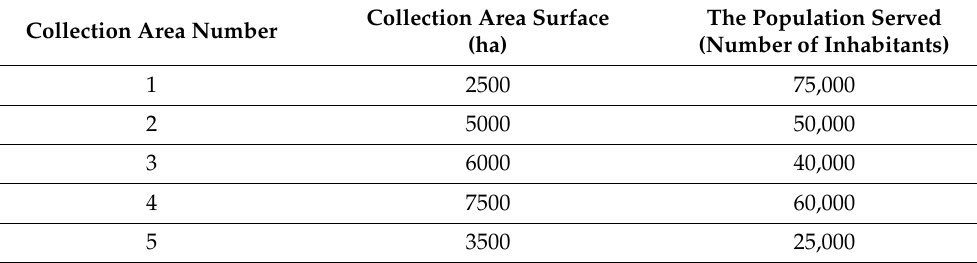
Table 1. The characteristics of the collection areas.